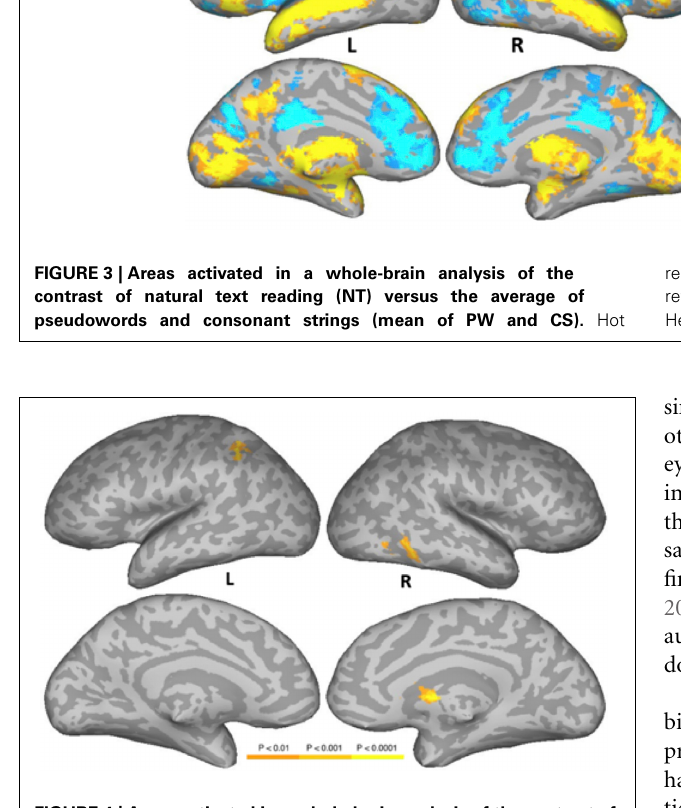
FIGURE 4 | Areas activated in a whole-brain analysis of the contrast of the pseudowords versus consonant string conditions. Hot regions represent more activation in the pseudowords condition than in the consonant string condition. L, Left Hemisphere; R, Right